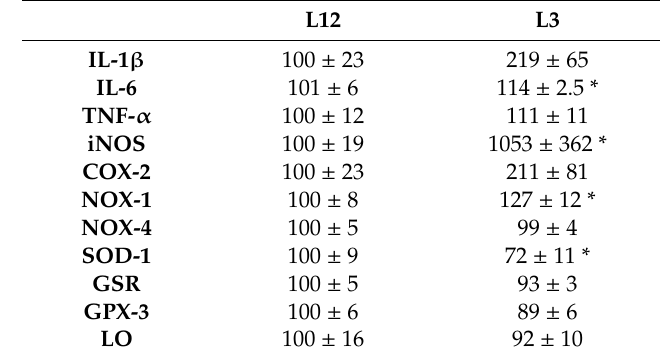
Table 4. Gene expression of interleukin 1-beta (IL-1 β ), interleukin- 6 (IL-6), tumor necrosis